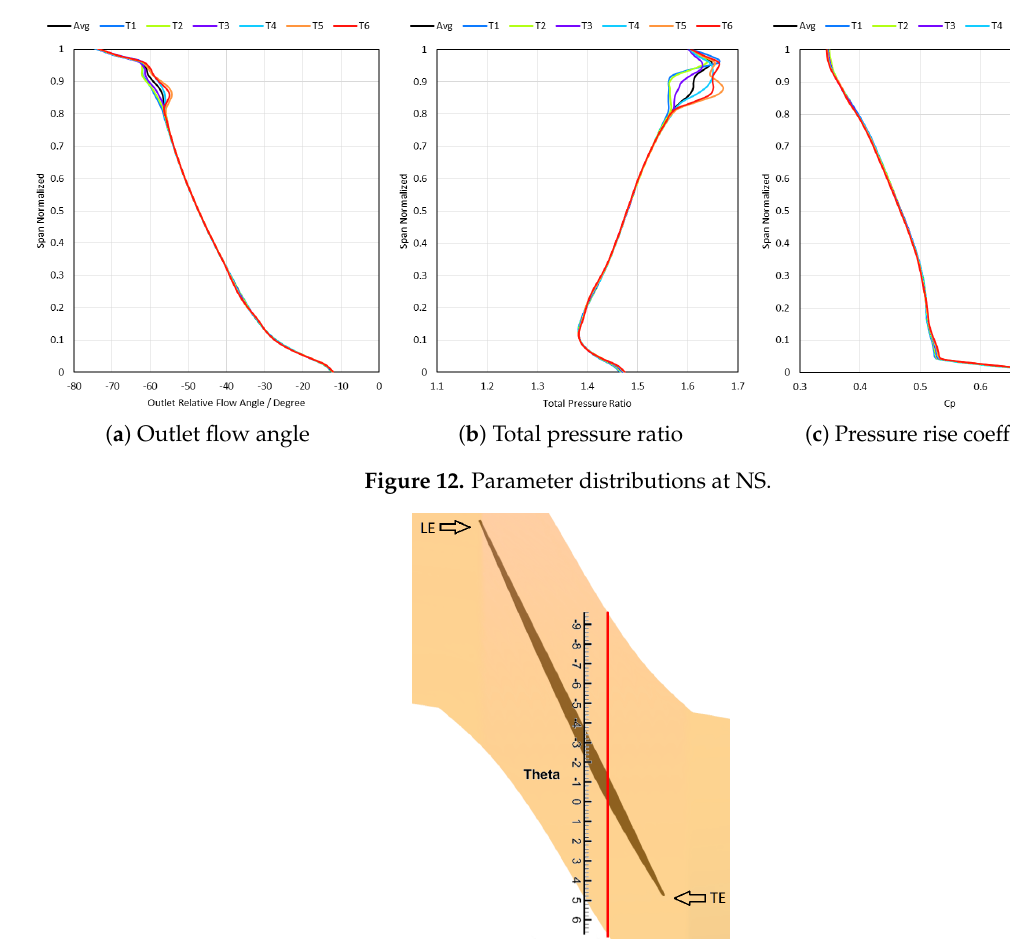
Figure 13. Circumferential line location on the shroud surface.